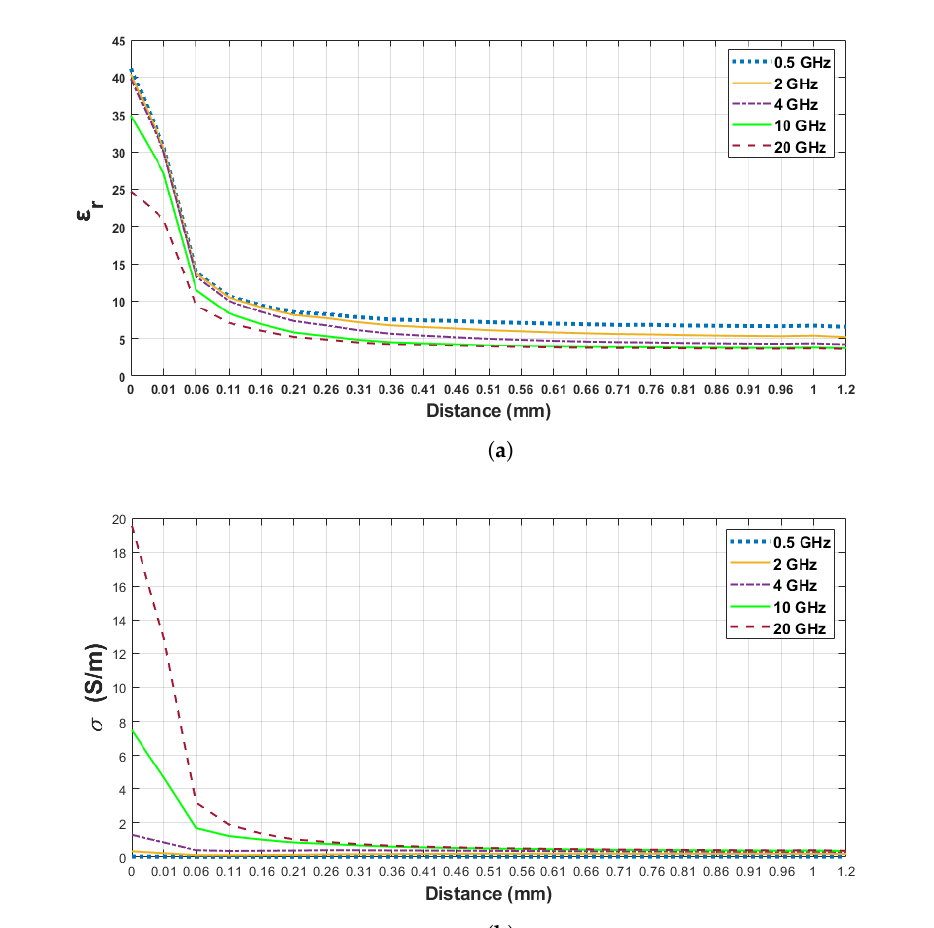
Figure 8. Retrieved dielectric properties of the double-layered skin–triton X-100 configuration: ( a ) relative permittivity, ( b ) conductivity as a function of probe’s distance from first layer at 0.5, 2, 4, 10 and 20